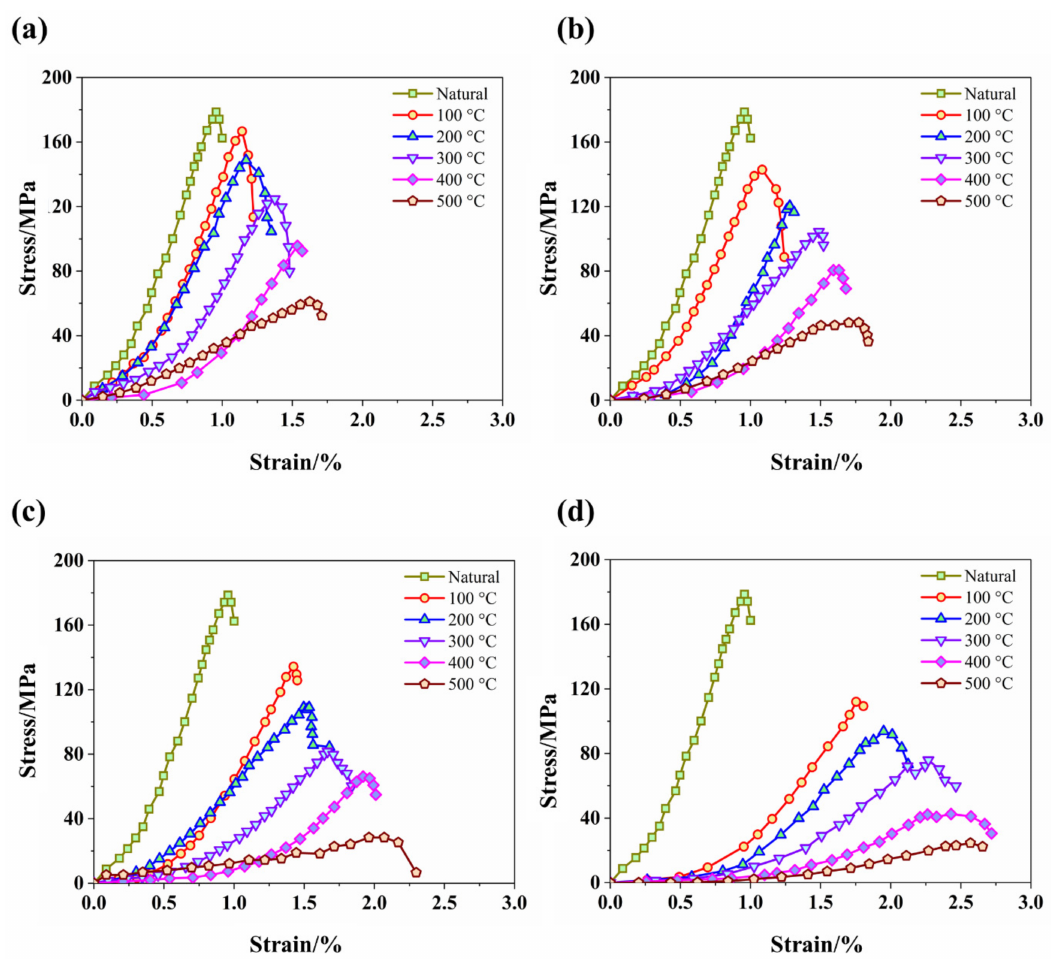
Figure 5. Stress–strain curve of granite subjected to thermal treatment: ( a ) 1 cycle, ( b ) 10 cycles, ( c ) 20 cycles, ( d ) 30